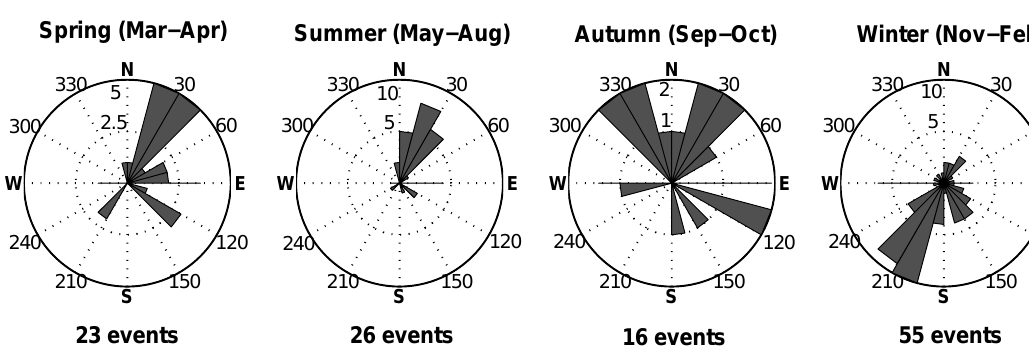
Fig. 7. Seasonal variations of the propagation directions of bands.